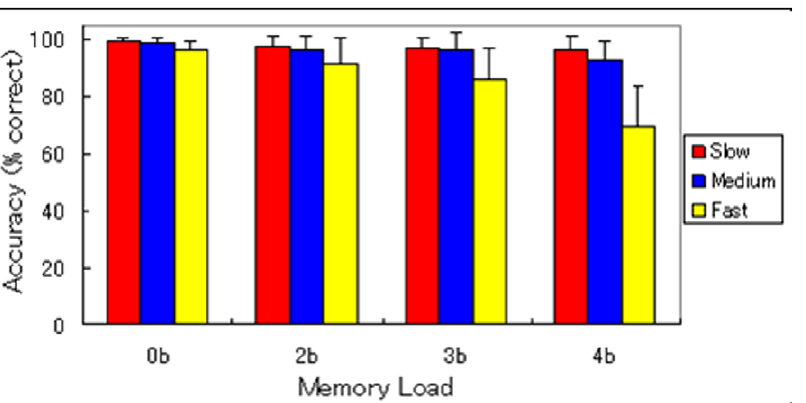
Figure 4. Behavioral results: accuracy across varying task speeds and memory loads. Error bars represent standard errors.